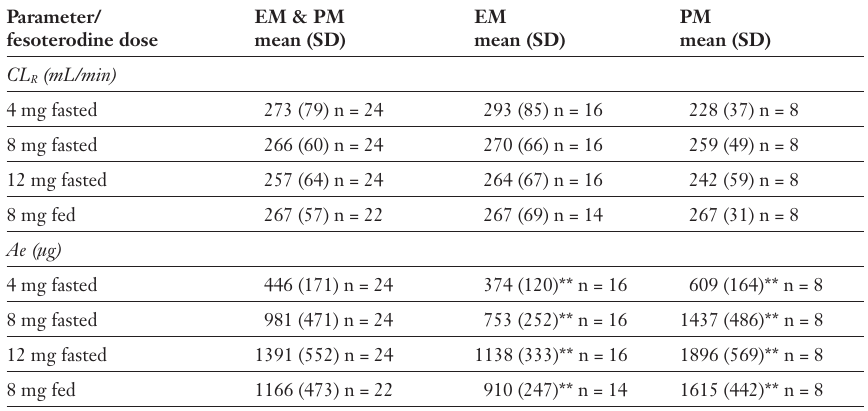
Urinary pharmacoki- netic parameters of 5-HMT following administration of